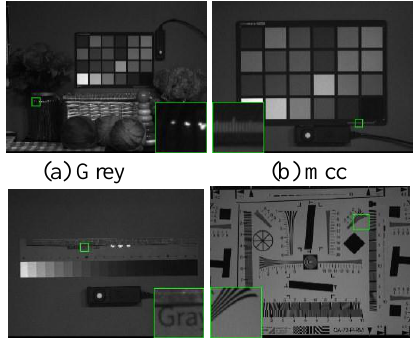
Figure 5. Real noise image preprocessing process